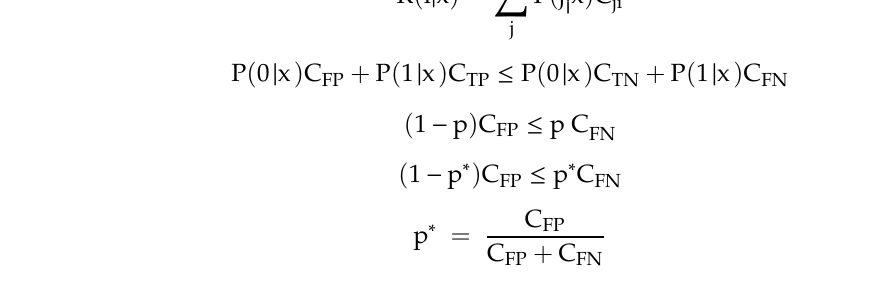
Table 2. The confusion matrix used in this